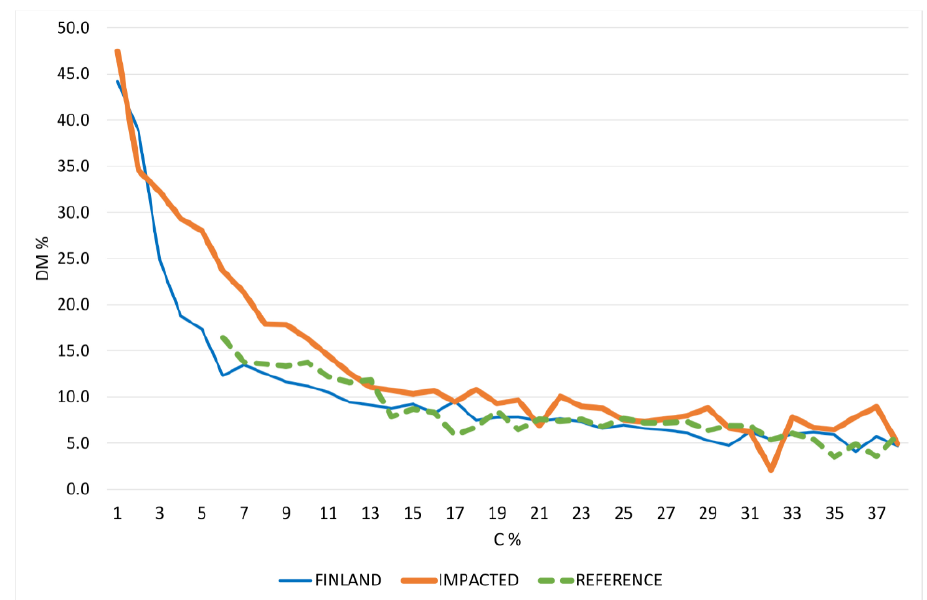
Figure 6. The average dry matter content in relation to average carbon content in the presently studied lake sediments compared with a dataset of lake sequences (area < 10 km 2 , sediment depth 0–30 cm, n = 570) from Finland [20].